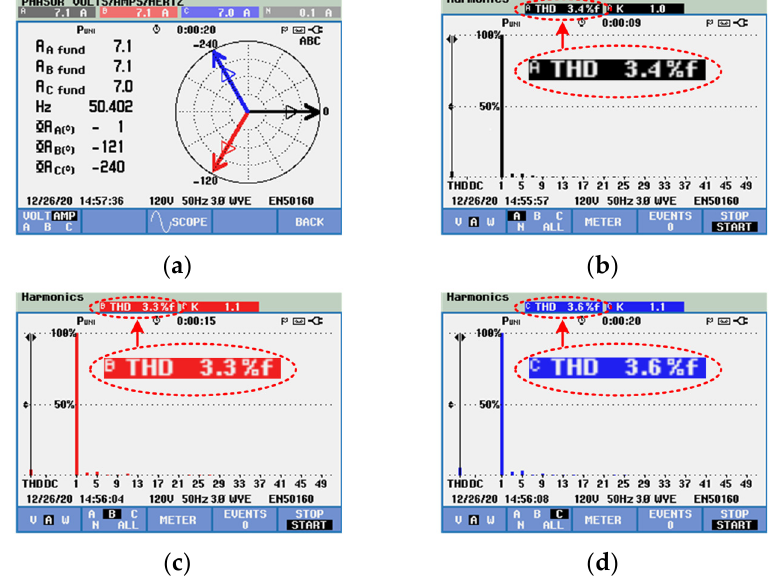
Figure 16. Power quality analysis results of the proposed methods. ( a ) The measurement results with; ( b ) THD of phase A grid-connected current; ( c ) THD of phase B grid-connected current; ( d ) THD of phase C grid-connected current.